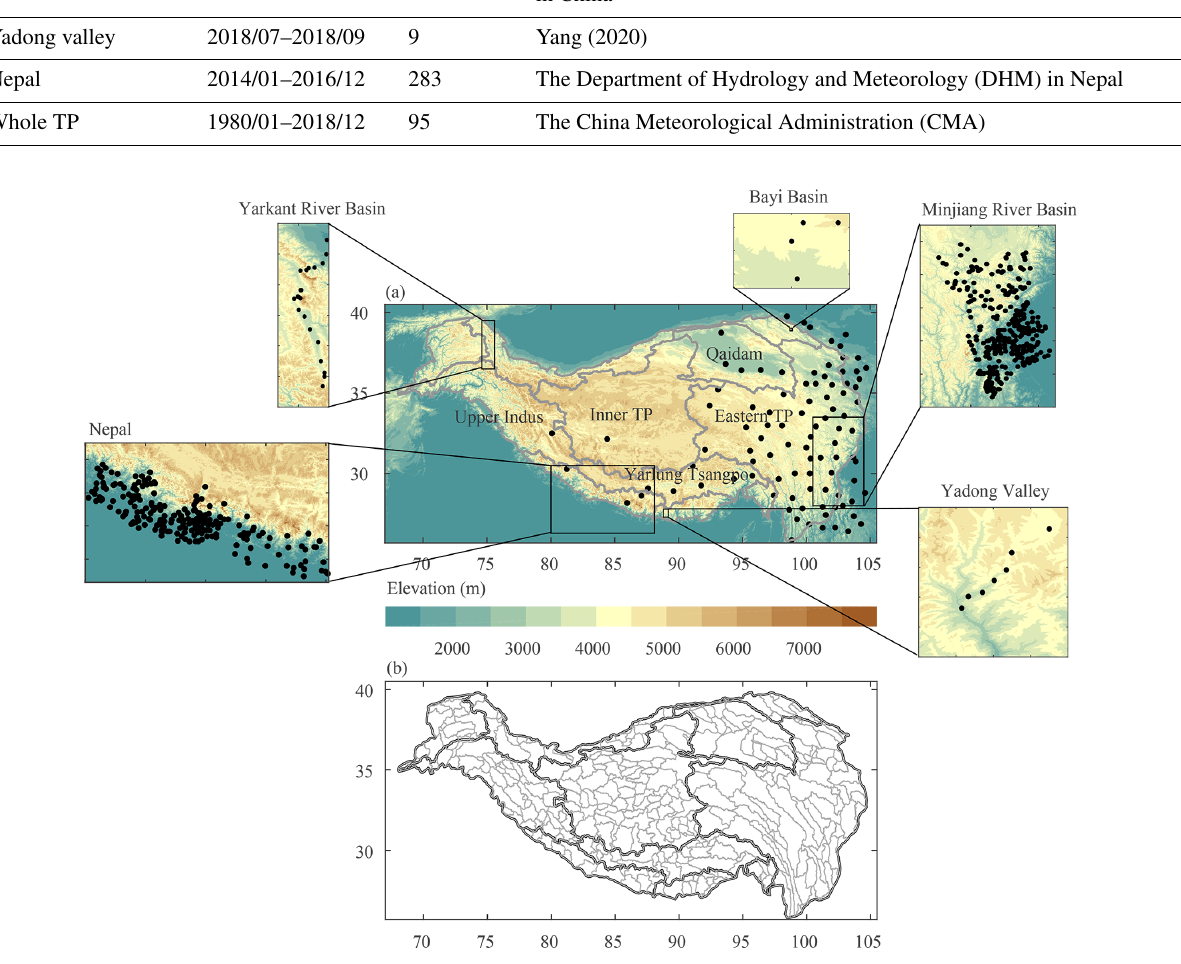
Figure 1. (a) Topography of the Third Pole (TP) region and the boundaries of five sub-regions of the TP, along with the distribution of the five rain gauge networks. The black points represent the rain gauges. (b) The boundaries of the 388 sub-basins in the TP. Fig. 1b shows the area above 2500ma.s.l. The boundaries of the TP and the five sub-regions are derived from Zhang